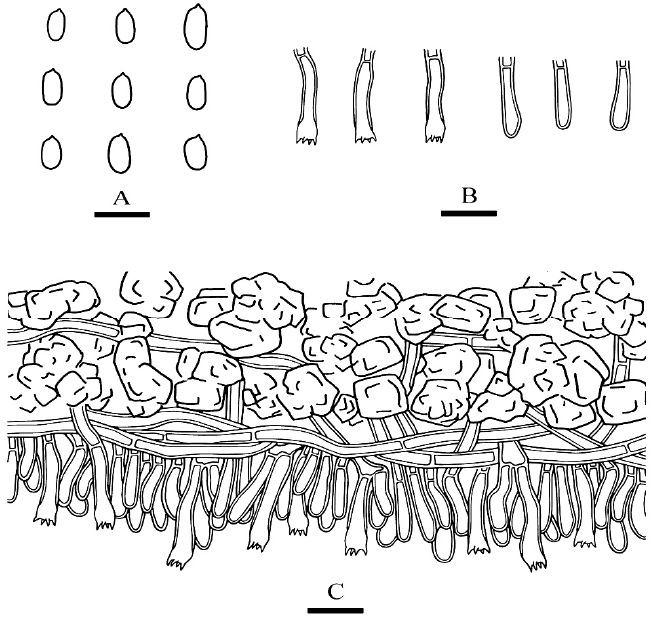
Figure 4. Microscopic structures of Phanerochaete pruinosa (holotype): basidiospores ( A ), basidia and basidioles ( B ), A section of hymenium ( C ). Bars: ( A ) = 5 µm, ( B , C ) = 10 µm. Additional specimen examined— China, Yunnan Province, Zixishan National For- estry Park, on fallen branch of angiosperm, 101.4° E, 25.1° N, 1 July 2018, C.L. Zhao 7112 (SWFC). Habitat and ecology— Climate of the sample collection site is monsoon humid, and the forest type is evergreen broad-leaved forest, and the samples were collected on an angiosperm branch. Phanerochaete rhizomorpha C.L. Zhao and D.Q. Wang sp. nov. Figures 5 and 6. MycoBank no.: MB 841272. Diagnosis: It differs from P. citrinosanguinea by its orange hymenial surface and larger cystidia 48.5–71.5 µm × 3–6.5 µm)